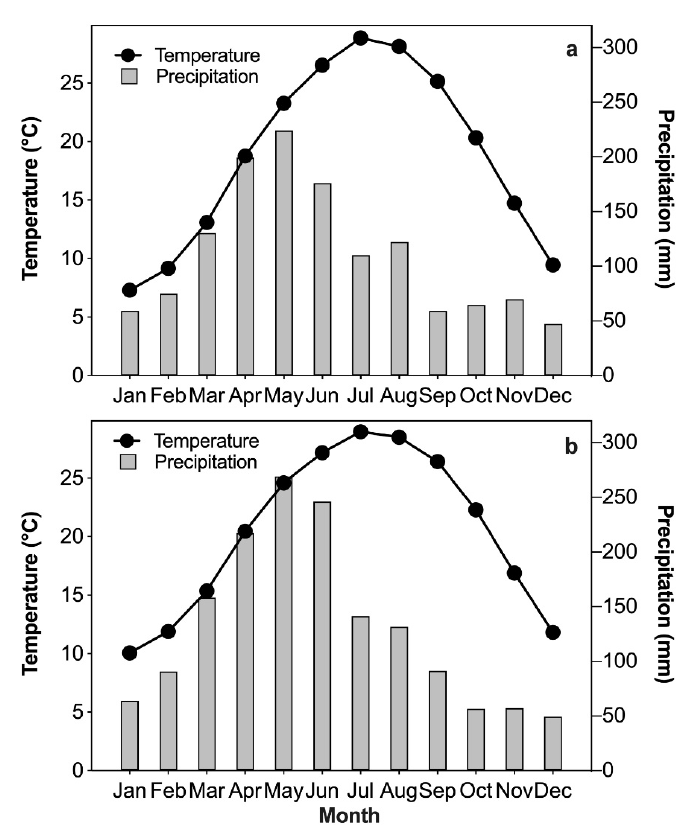
Figure 3. Monthly mean temperature (line with symbols) and monthly total precipitation (bar) from ( a) Daoxian (1960–2016) and ( b) Shaoguan (1951–2016) meteorological stations.